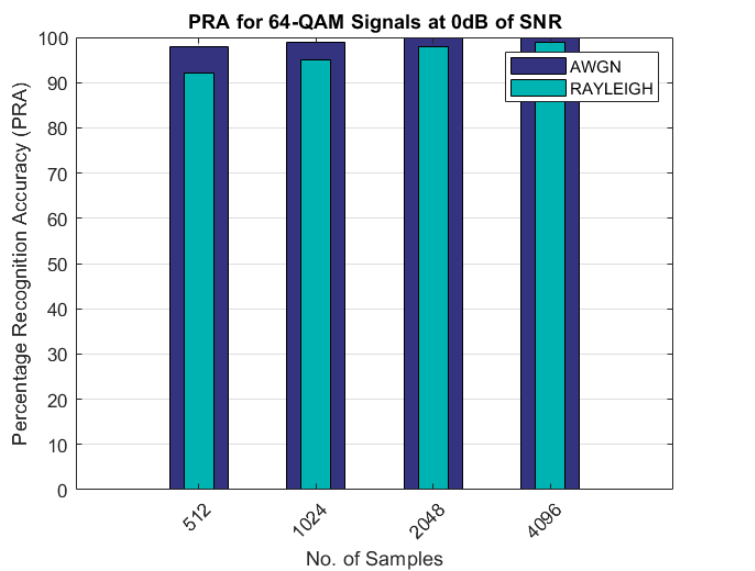
Figure 7. PRA for 64-QAM signals.